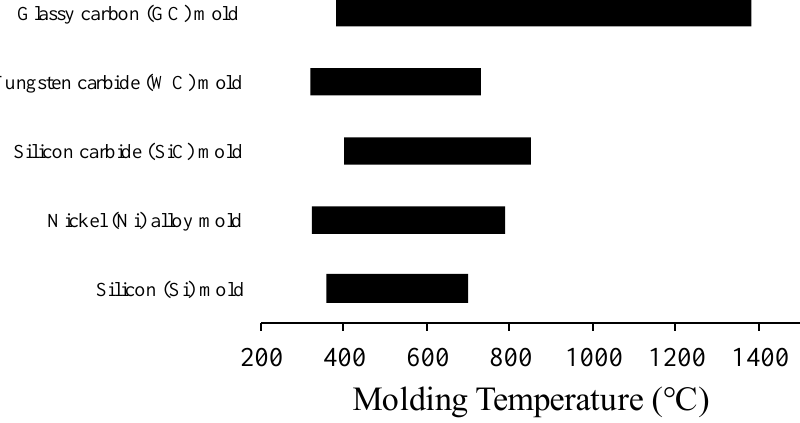
Figure 9. Comparison of molding temperatures for different mold types.